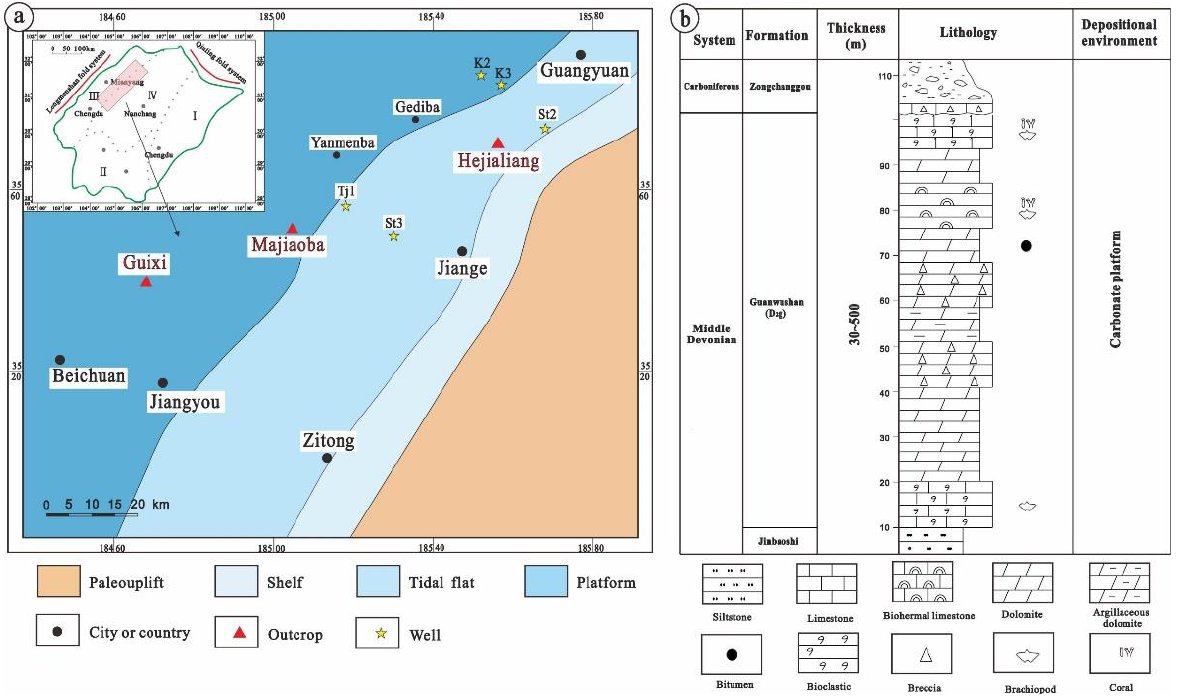
Figure 1. ( a ) Location and paleogeographic setting of the study area during deposition of the GWSF; ( b ) Schematic of the stratigraphy and sedimentology of the GWSF.